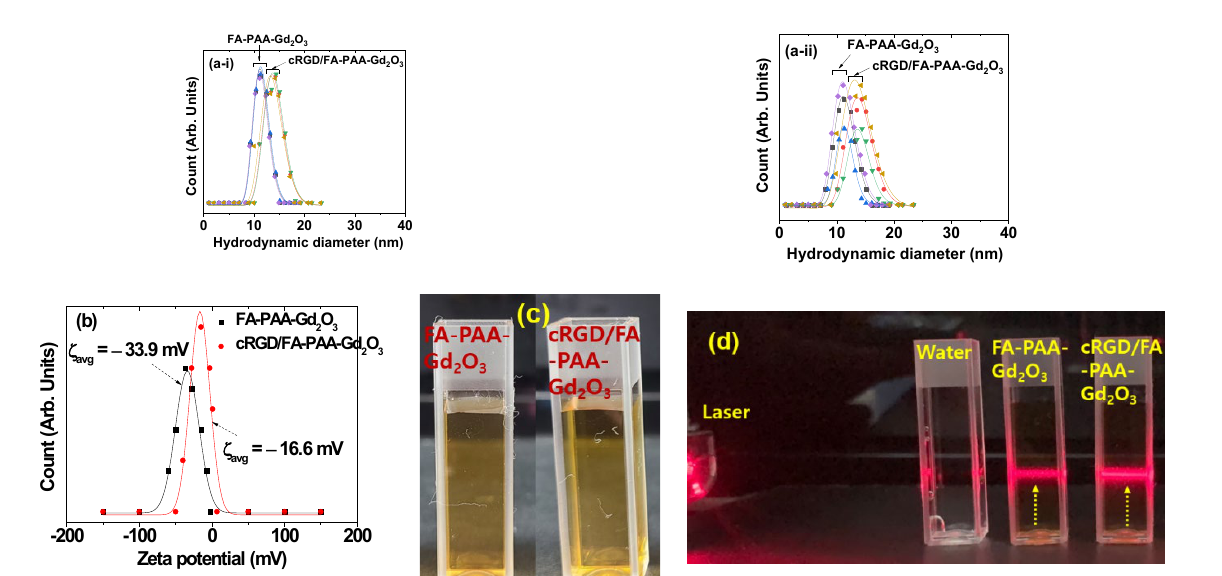
Figure 3 . DLS patterns of the FA-PAA-Gd 2 O 3 and cRGD/FA-PAA-Gd 2 O 3 nanoparticles in ( a-i ) aqueous media and ( a-ii ) physiological solution (0.9 NaCl wt.% in water); the a avg values as estimated using log-normal function fits to the observed DLS patterns. DLS patterns were measured three times; ( ■ , ▲ , ♦ ) for FA-PAA-Gd 2 O 3 nanoparticles and ( ● , ▼ , ◄ ) for cRGD/FA-PAA-Gd 2 O 3 nanoparticles. ( b ) Zeta potentials of the FA-PAA-Gd 2 O 3 and cRGD/FA-PAA-Gd 2 O 3 nanoparticles in aqueous media. ( c ) FA-PAA-Gd 2 O 3 and cRGD/FA-PAA-Gd 2 O 3 nanoparticles in aqueous media, exhibiting excellent colloidal stability (no precipitation for >1 year after synthesis). ( d ) Tyndall effect, confirming the colloidal dispersion of the FA-PAA-Gd 2 O 3 and cRGD/FA-PAA-Gd 2 O 3 nanoparticles in aqueous media; no laser light scattering is observed in triple-distilled water. Arrows indicate laser light scattering by the nanoparticle colloids.